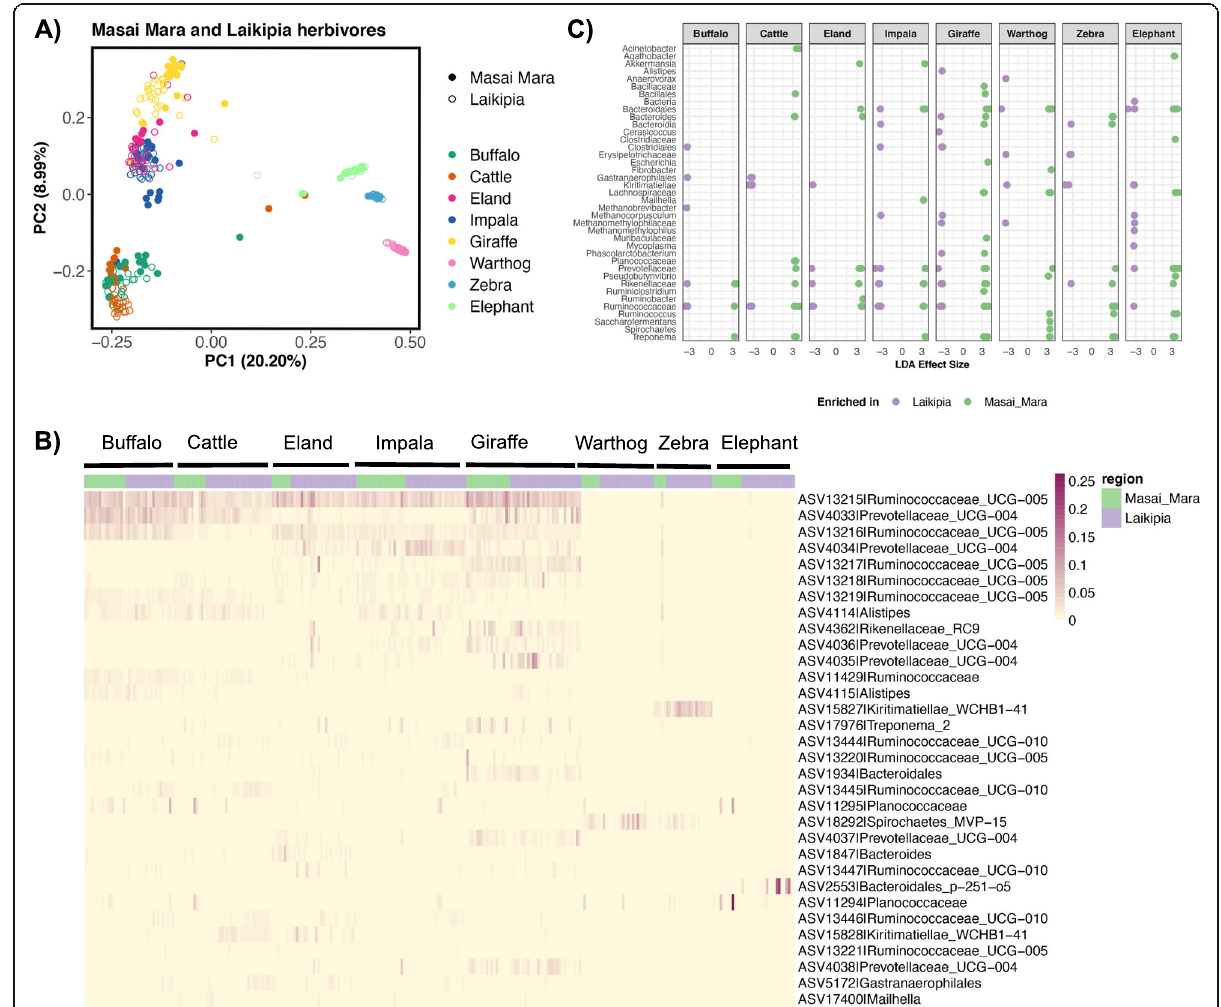
Fig. 4 The gut microbiotas of conspecific African herbivores broadly converge, but also exhibit differences in their ASV abundances. We compared the gut microbiotas of eight species of herbivores residing in both the Masai Mara (this study) and Laikipia (Kartzinel et al. 2019) regions in Kenya. a PCoA plot constructed from Bray-Curtis dissimilarity matrices. Each point represents a sample and is color-coded by host species; shape shading indicates geographic region (empty circles: Masai Mara, filled circles: Laikipia). b Heatmap of the 32 most abundant bacterial ASVs residing in the gut microbiotas of Masai Mara and Laikipia herbivores. Samples are grouped by host species, and are color-coded by host geographic region. c ASVs enriched in Masai Mara or Laikipia herbivores as determined by LEfSe. Each dot represents a unique ASV and is color-coded by host geographic region. A total of 212 ASVs are displayed (those with LDA > 3.2) and their family or genus level classification are on the